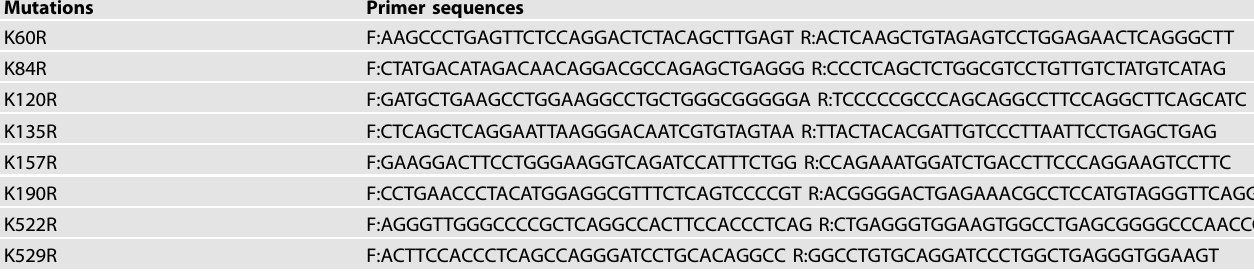
Table 3. Primer sequences used for the introduction of Flag-CPNE1